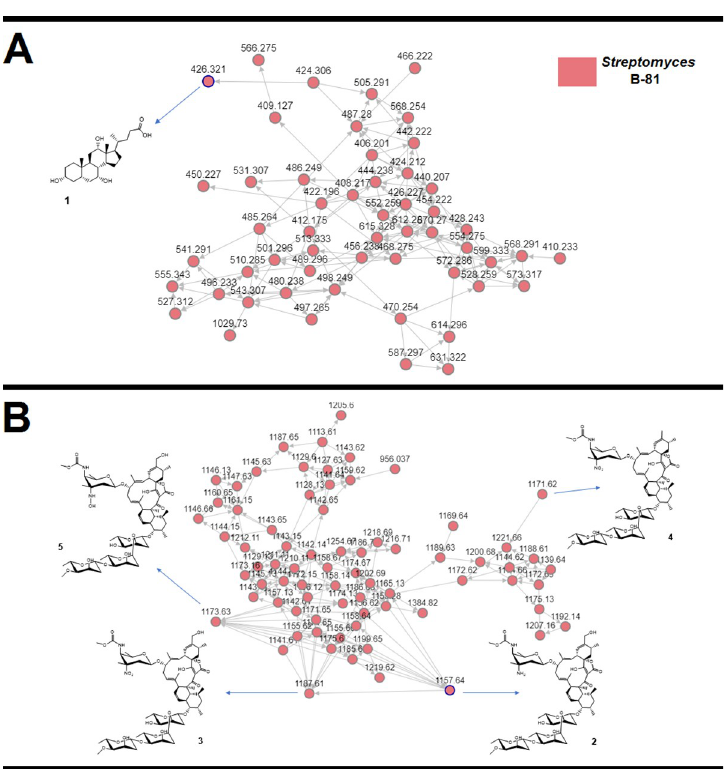
Fig 3. Molecular networking obtained for Streptomyces sp. MW562807 extract Cholic Acid and its derivatives were grouped in cluster A, and Lobophorins were grouped in cluster B. Nodes circled in blue indicate molecules identified by comparison with the GNPS platform